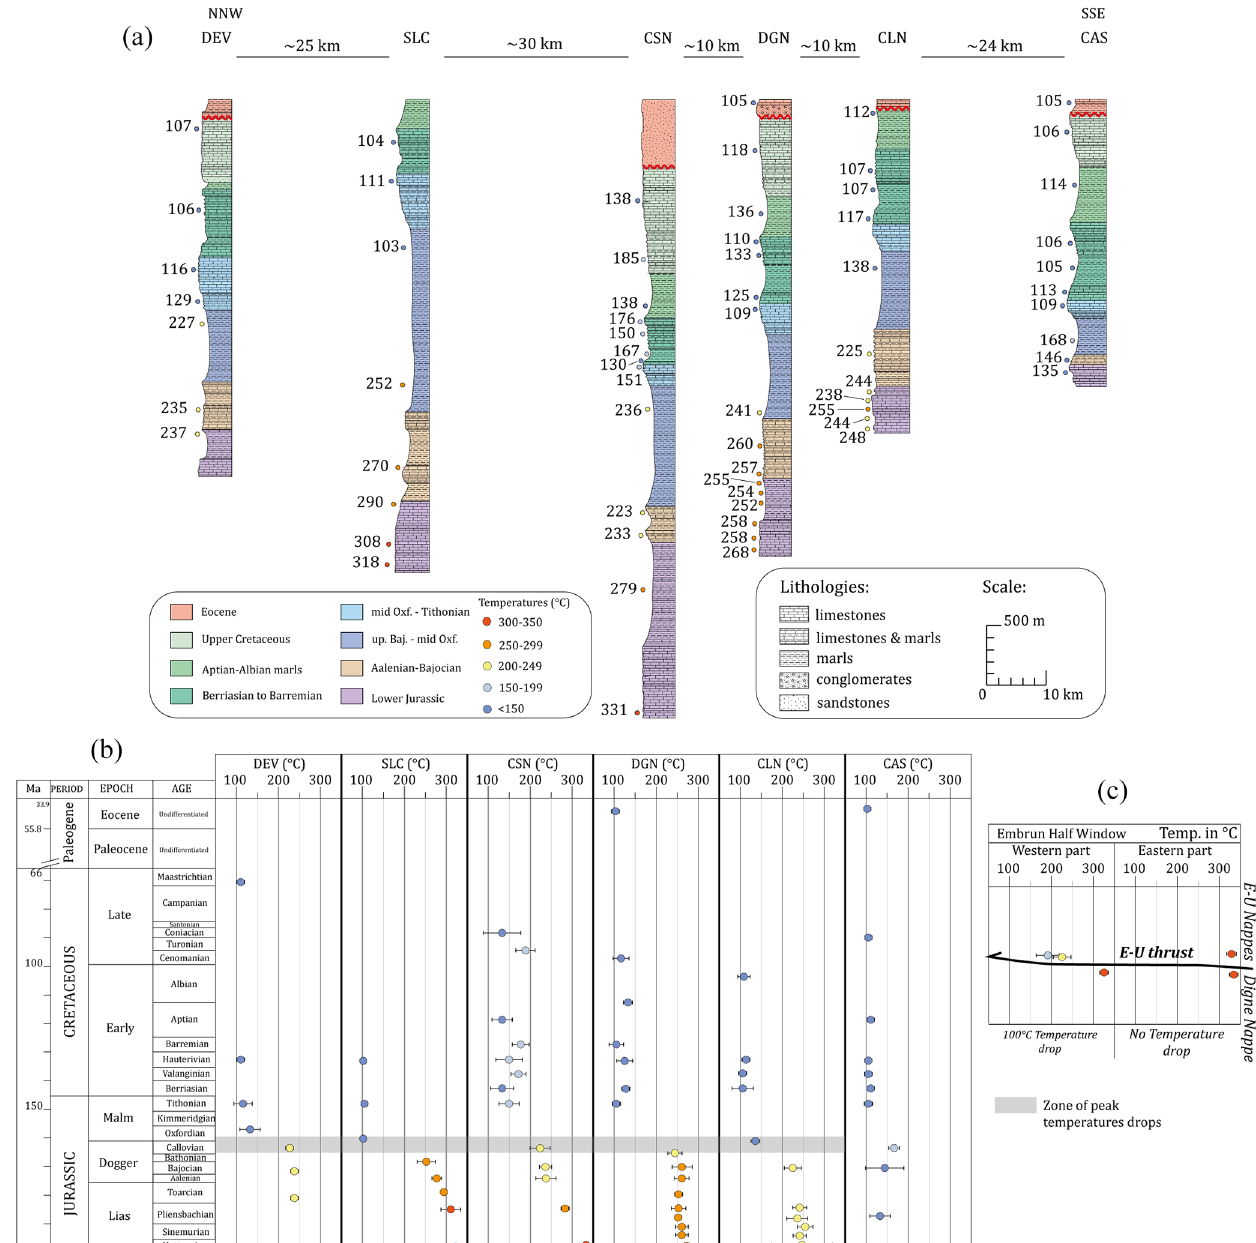
Figure 3. (a) Stratigraphic sections along the front of the Digne Nappe with the RSCM-derived peak temperatures. See Data Repository 1 for details about the samples and Fig. 1 for the location of the sections. (b) Evolution of the RSCM temperatures through geological time scale along the sedimentary columns and (c) in two locations of the Embrun half